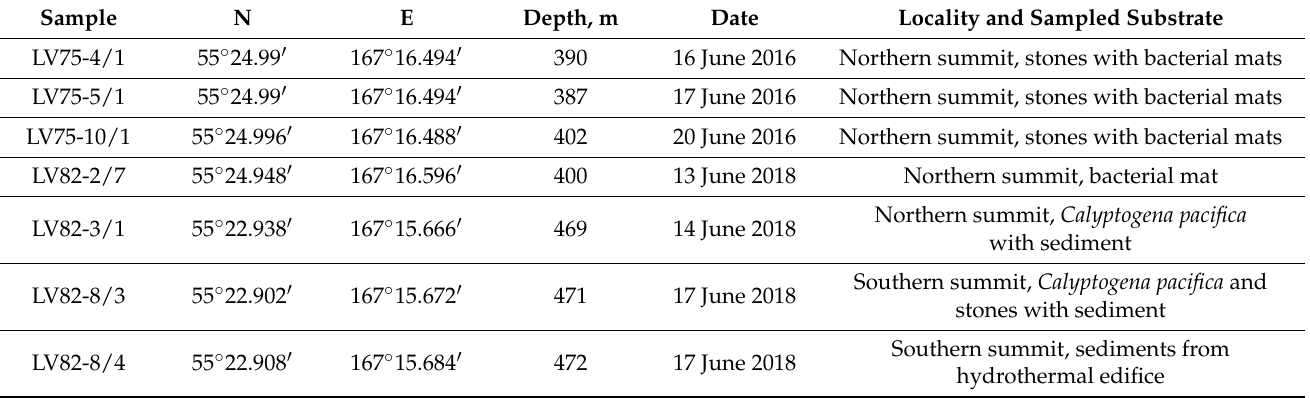
Table 1. Sampling localities of provannid snails on Piip Volcano.